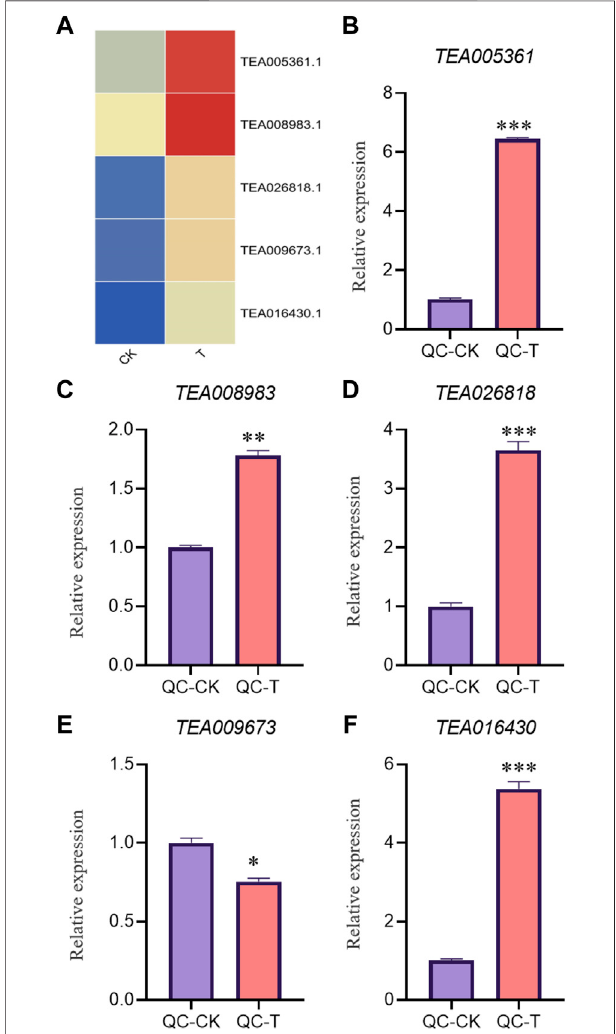
FIGURE 8 | QC-CK&QC-T Comparison of unregulated genes expression pattern between RNA-Seq and qRT-PCR results. The gene expression values were normalized to the Actin gene. The purple column represents the results of drought treatment for 0 days, and the orange red column represents the results of drought treatment for 20 days. CK: Cutting samples treated with drought for 0 days, T: Cutting samples treated with drought for 20 days. ** p < 0.01, *** p <